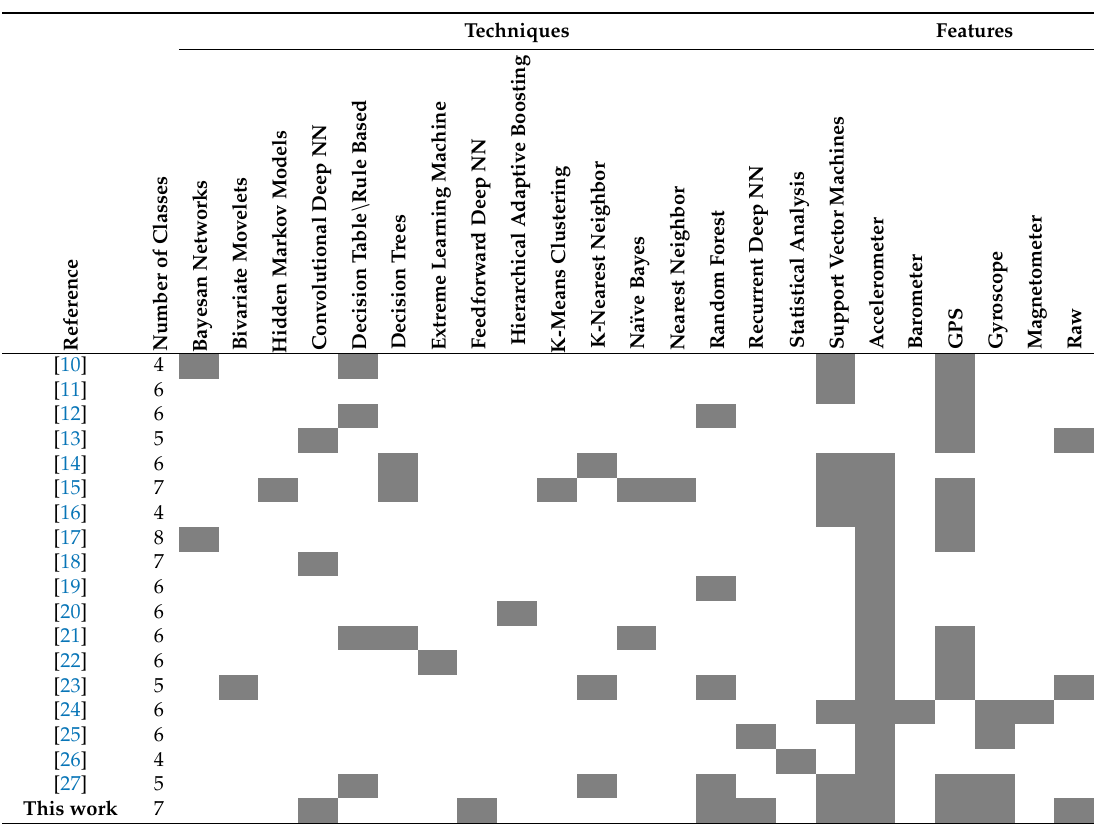
Table 1. State-of-the-art